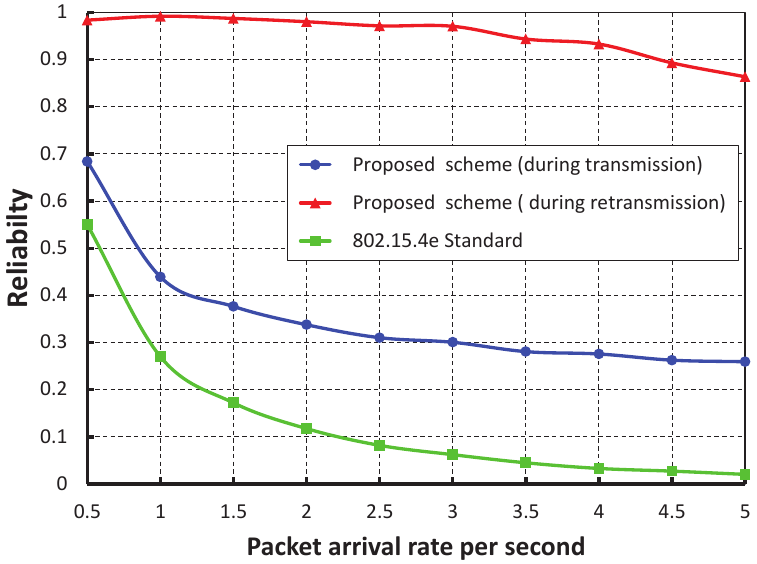
Figure 14. Comparison of the reliability of our proposed scheme with the IEEE 802.15.4e